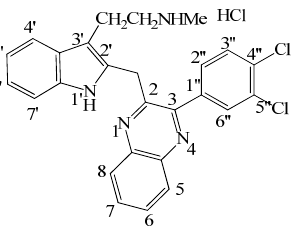
Figure 11. Chemical structure of compound 4b .